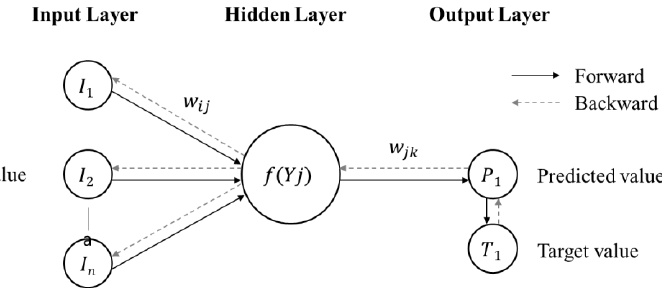
Figure 1. Backpropagation algorithm of a multilayer ANN.